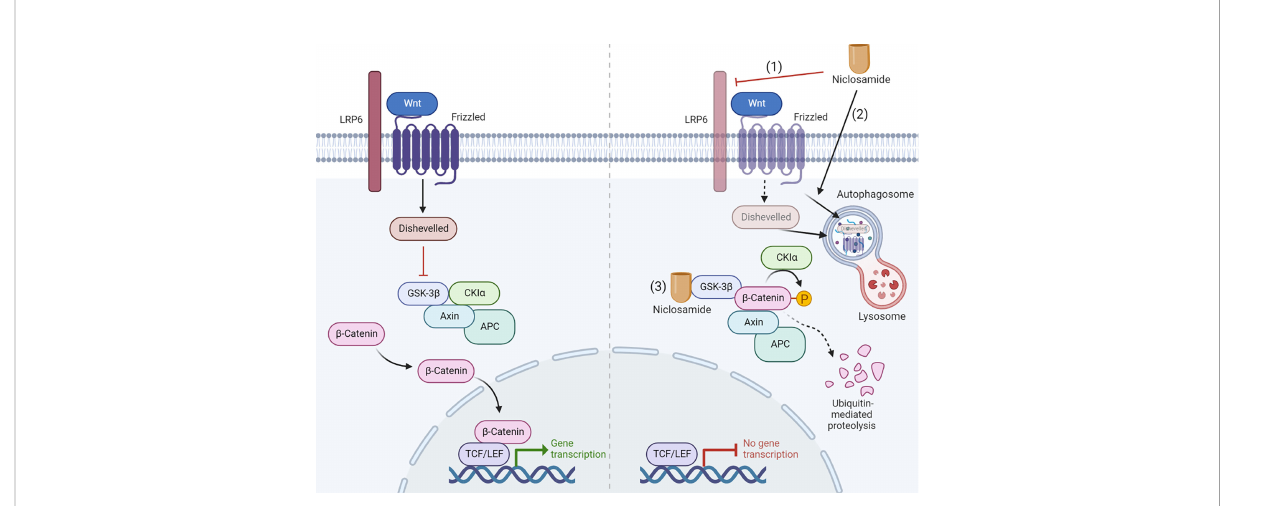
FIGURE 4 Niclosamide inhibits Wnt pathway through multiple mechanism. The Wnt pathway inhibition by niclosamide depends on multiple ways of action: (1) Niclosamide suppresses LRP6 expression. (2) Niclosamide promotes the degradation of Frizzled 1 and Dishevelled-2 through autophagy. (3) Niclosamide binds GSK3 directly, resulting in disruption of the Axin-GSK3 complex and attenuation of canonical Wnt activity. Created with